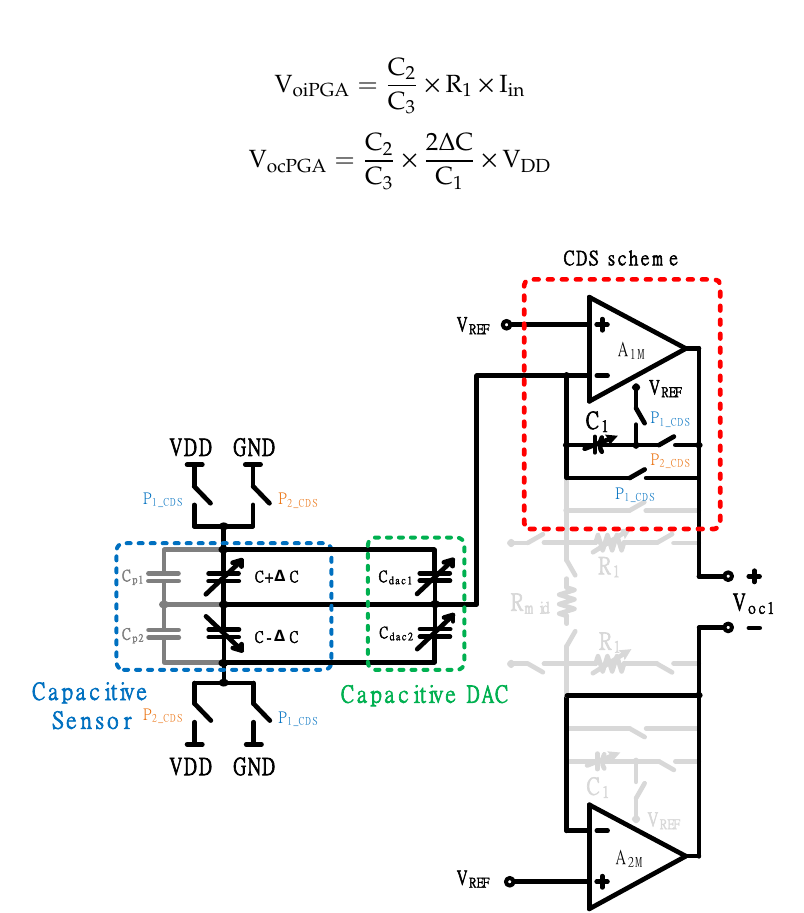
Figure 3. Configuration of the capacitive-sensing mode. CDS: correlated double sampling, DAC: digital-to-analog converter.